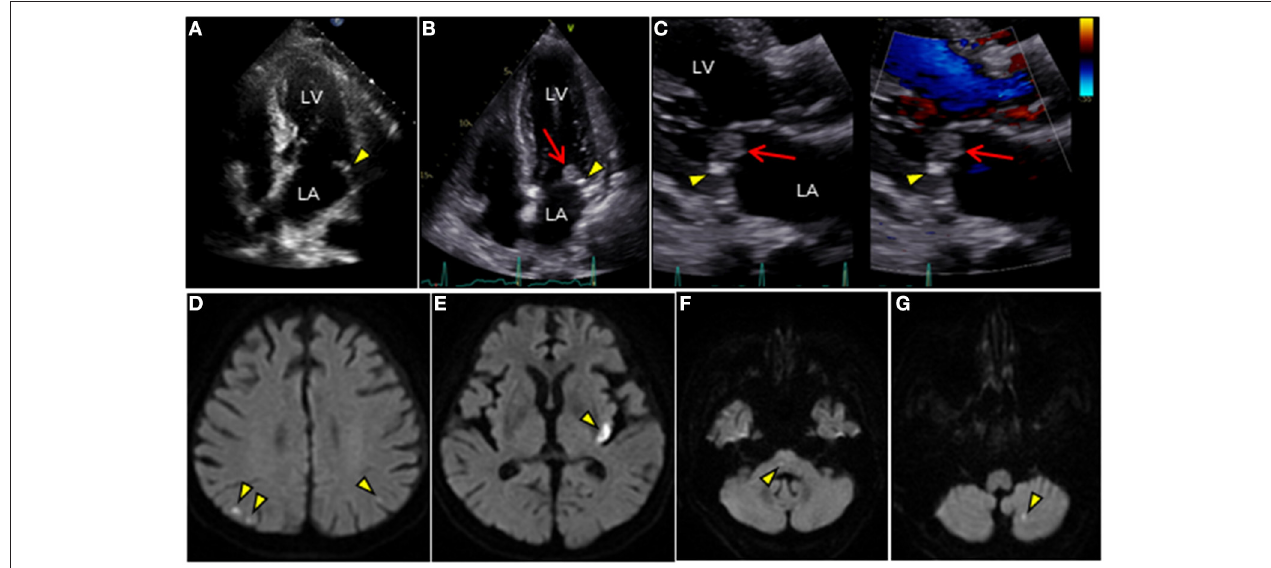
FIGURE 1 | TTE and brain MRI. (A–C) Longitudinal TTE: (A,B) apical 4-chamber and (C) parasternal long-axis views. (A) TTE shows tiny MAC along the posterior mitral annulus 1 year ago (arrowhead). (B,C) TTE after admission shows MAC progression (arrowhead) and a large round mass superimposed on the MAC (arrow). Mass with wide attachment (10 × 11mm in size) is characterized by heterogeneity and oscillation. (C) Notably, color Doppler TTE showed no significant mitral regurgitation. (D–G) Brain diffusion-weighted MRI detects multiple acute cerebral infarctions in both hemispheres (arrowheads). LA, left atrium; LV, left ventricle; MAC, mitral annular calcification; MRI, magnetic resonance imaging; TTE, transthoracic